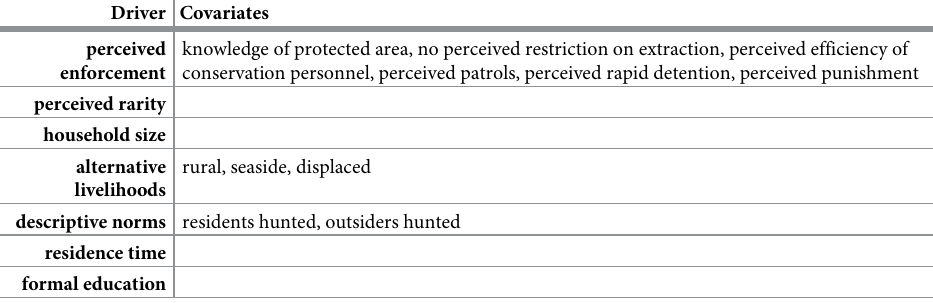
Table 2. Drivers and covariates. Hypothesized drivers of non-compliant behavior and corresponding measured covariates in the Sierra Leone dataset. Driver